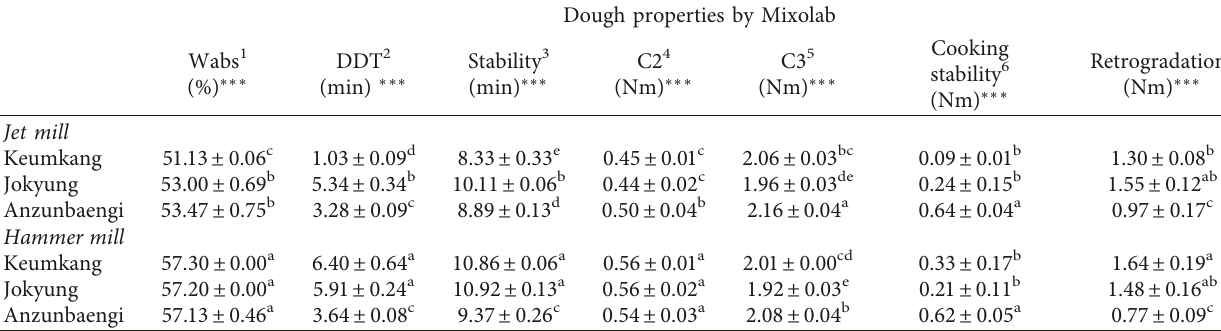
Table 4: Dough properties of WWFs milled with jet mill and hammer mill. Dough properties by